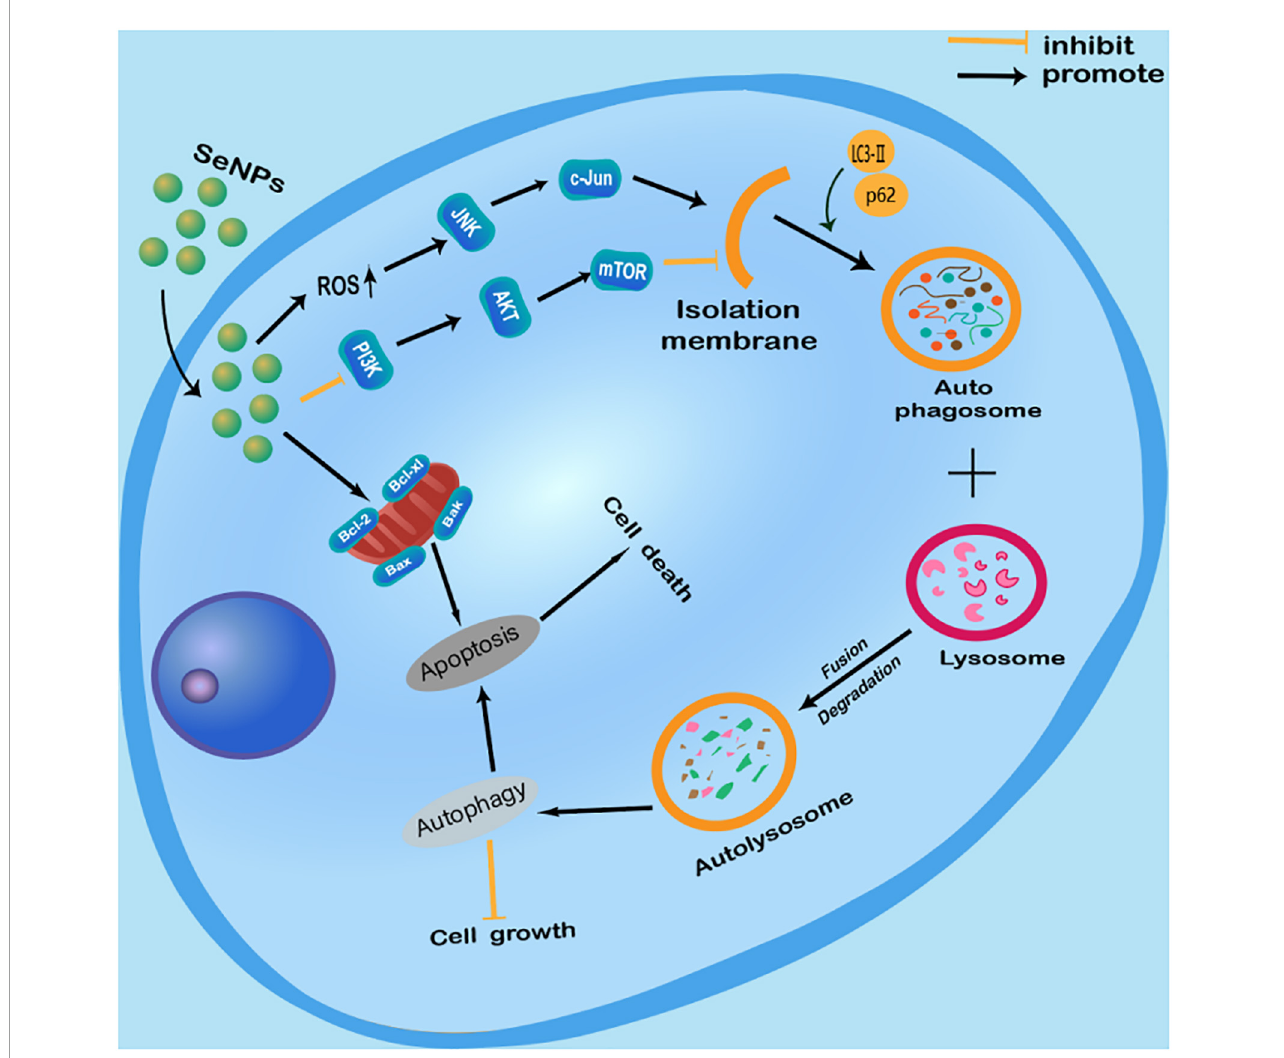
FIGURE2 Anticancer effects of selenium nanoparticles (Se NPs) by promoting cancer cell autophagy through the regulation of reactive oxygen species (ROS)-mediated c-Jun N-terminal kinase pathway and PI3K/Akt/mTOR pathway.